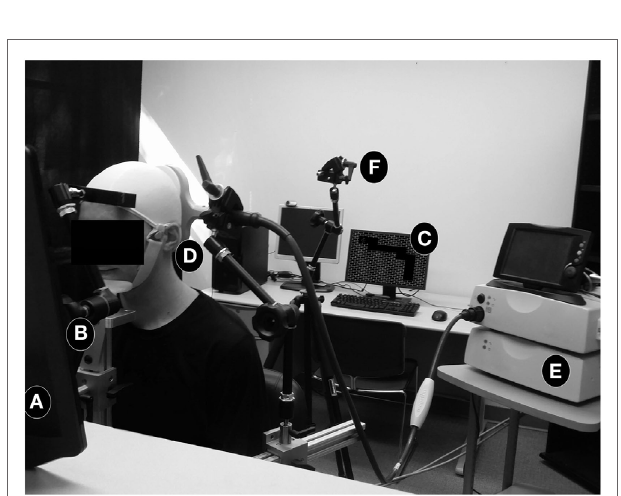
FigUre 4 | Depiction of the experimental setup . The subject sat on a BrainSight ™ chair (Rogue Research, Montreal, QC, Canada) with a white swim cap in front of a touch screen monitor (a) with their head situated in a two-pronged head-and-chin-rest (B) . The current maze was displayed to the experimenter on a separate monitor not visible to the subject (c) . A figure-eight TMS coil (D) was situated over the stimulation site in the orientation shown. The angle of the coil was consistent across all subjects. In the control condition, the coil was covered by the control prop (partially visible in the figure; see Figure 3 ). The coil, powered by a MagStim Super Rapid2 stimulator (e) , was positioned using a laser pointer (F) at the beginning of every maze game.